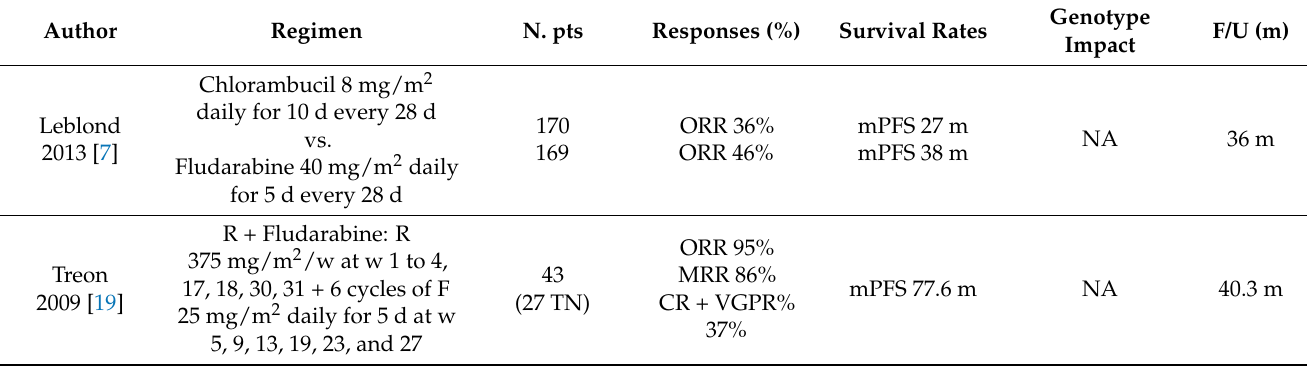
Table 1. Summary of main regimens employed in previously untreated WM